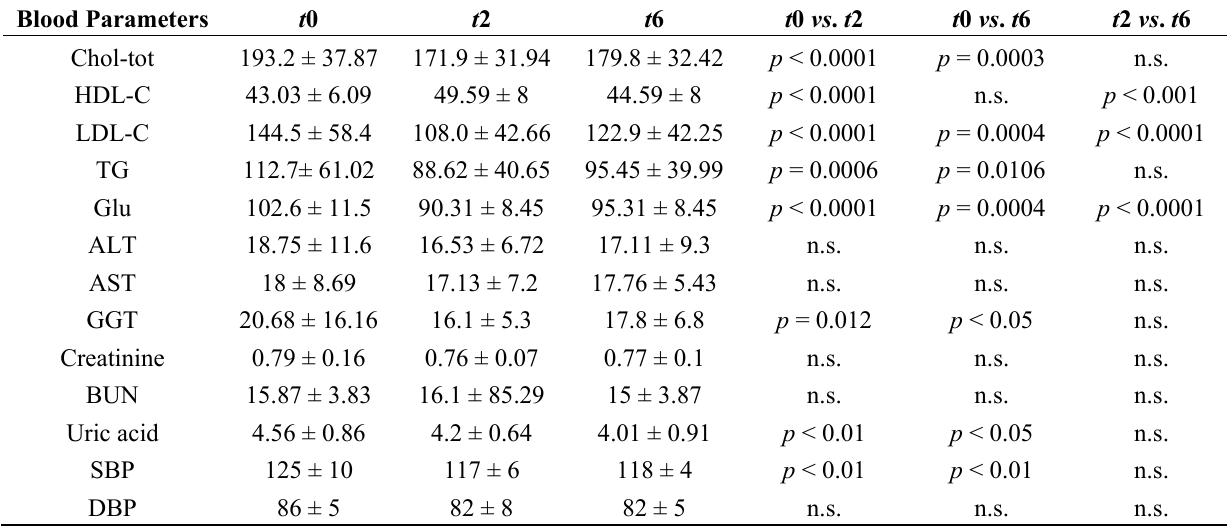
Table 3. Changes in blood biochemical and pressure parameters at baseline ( t 0), after first period of ketogenic diet and low carbohydrate diet ( t 2) and after one year from the start ( t 6). Values are expressed as mean and standard